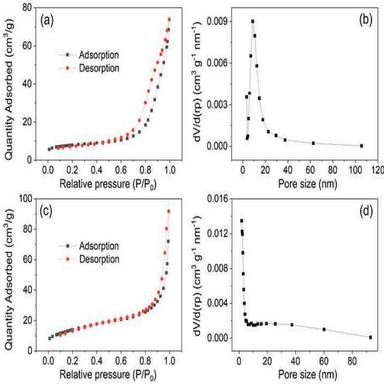
(a) The nitrogen adsorption-desorption isotherms and (b) pore size distribution of CuCo2O4/CuO microspheres, and (c) the nitrogen adsorption-desorption isotherms and (d) pore size distribution of CuCo2O4/CuO nanosheets.